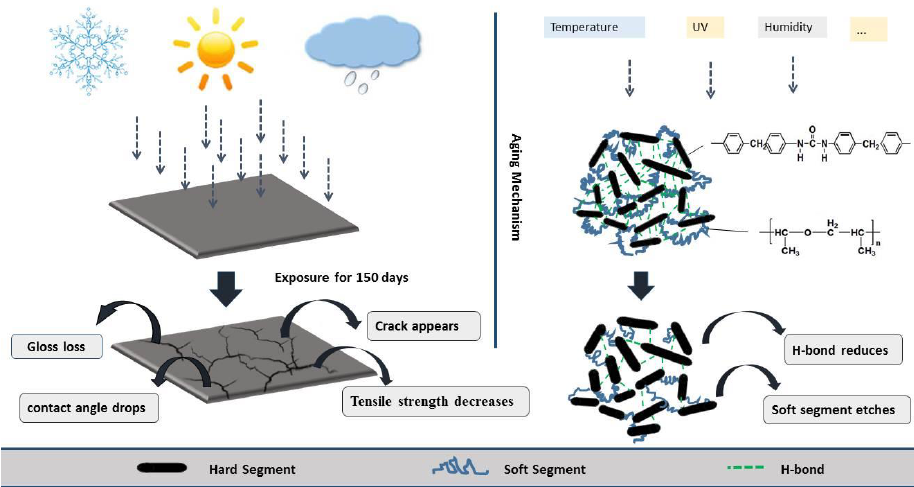
Scheme 1. Schematic illustration of the aging mechanism of polyurea